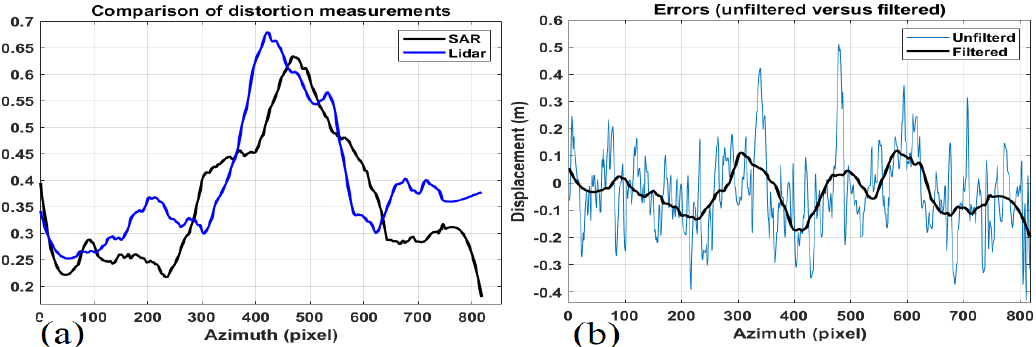
Figure 20. Displacement measurements. ( a ): SAR displacement. ( b ): Lidar displacement. For ( a , b ), the blue functions are the unfiltered trends, while the black plot are filtered. ( c ): Comparison of SAR versus Lidar displacement measurements.